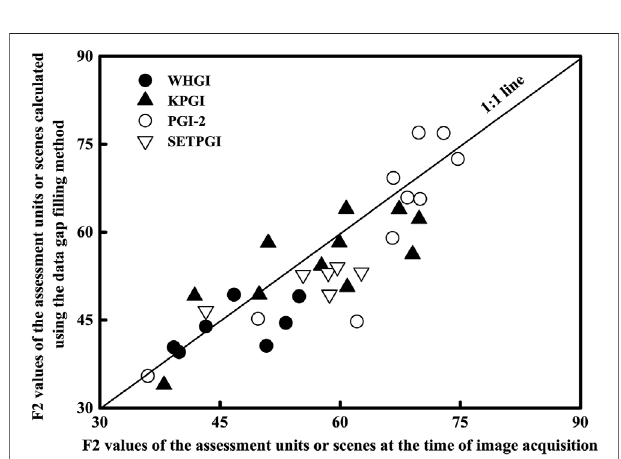
FIGURE 7 | Comparison of the F2 values of the assessment units or scenes at the time of image acquisition, with those of the same assessment units calculated using the data gap fi lling